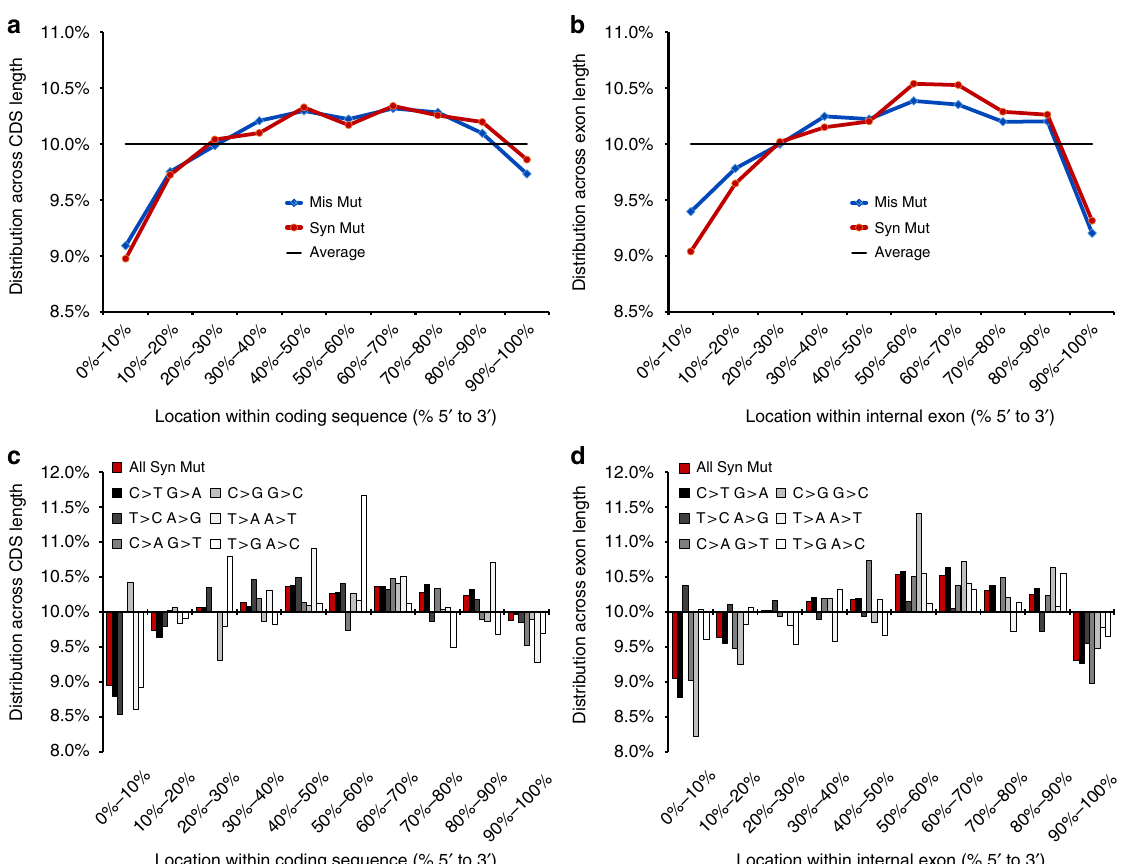
Fig. 2 Depletion of mutations towards the ends of coding regions and exons. a The distribution of the positions within the coding region of all mutations in all affected genes independent of their length is depicted in 5'-to-3' direction. The black line at 10% frequency would indicate equal distribution along the 10 bins of the coding sequence length. Synonymous mutations (Syn Mut), as well as missense mutations (Mis Mut) are depleted towards the 5'-end of the coding region. b The distribution of mutations within internal exons of multiexonic transcripts is depicted in 5'-to-3' direction. The black line at 10% frequency would indicate equal distribution along the 10 bins along the internal exon length. Synonymous mutations (Syn Mut), as well as missense mutations (Mis Mut) are depleted towards both ends of the exon. c The distribution of synonymous mutations along the coding sequence is depicted separately for six groups of possible nucleotide changes in point mutations. A 10% frequency would indicate equal distribution along the 10 bins of the coding sequence length. d The distribution of synonymous mutations along the length of internal exons is depicted separately for six groups of possible nucleotide changes. A 10% frequency would indicate equal distribution along the 10 bins of the internal exon